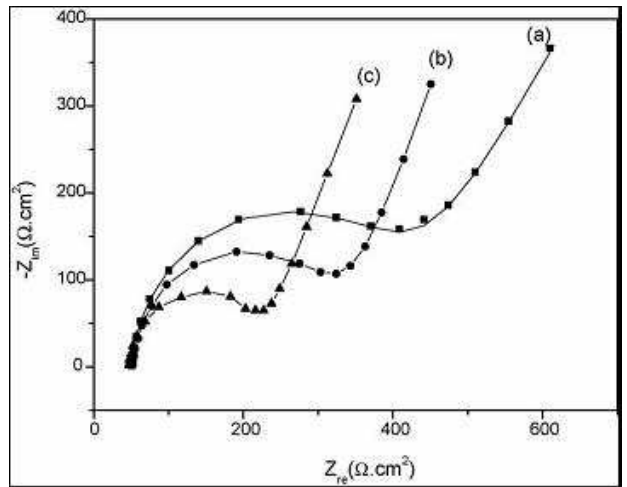
Figure 3. Nyquist diagram (Z vs. Z ) for the non-faradaic impedance measurements corresponding re im to: (a) magnetic microbeads/Au-electrode; (b)anti-atrazine-Fab fragment K47 antibody/ magnetic microbeads/Au-electrode; (c) 600ng.ml -1 of atrazine/ anti-atrazine-Fab fragment K47 antibody/ magnetic microbeads/Au-electrode; Solid curve show the computer fitting of the data using Randles’equivalent circuit. Symbols show the experimental data ( Reprinted from [7] with permission from Elsevier